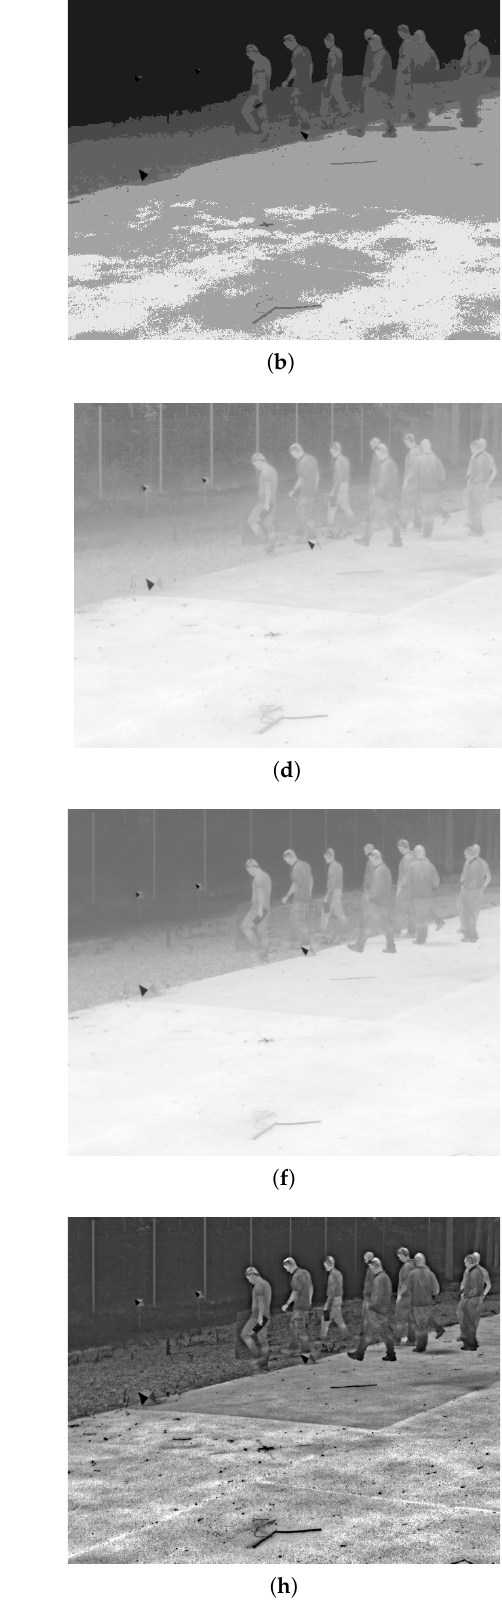
Figure 6. Comparison Results 3 (Low Contrast Image). ( a ) Linear Mapping. ( b ) HE. ( c ) CLAHE. ( d ) AHPBC. ( e ) MSR. ( f ) Reinhard. ( g ) LEP. ( h ) Proposed